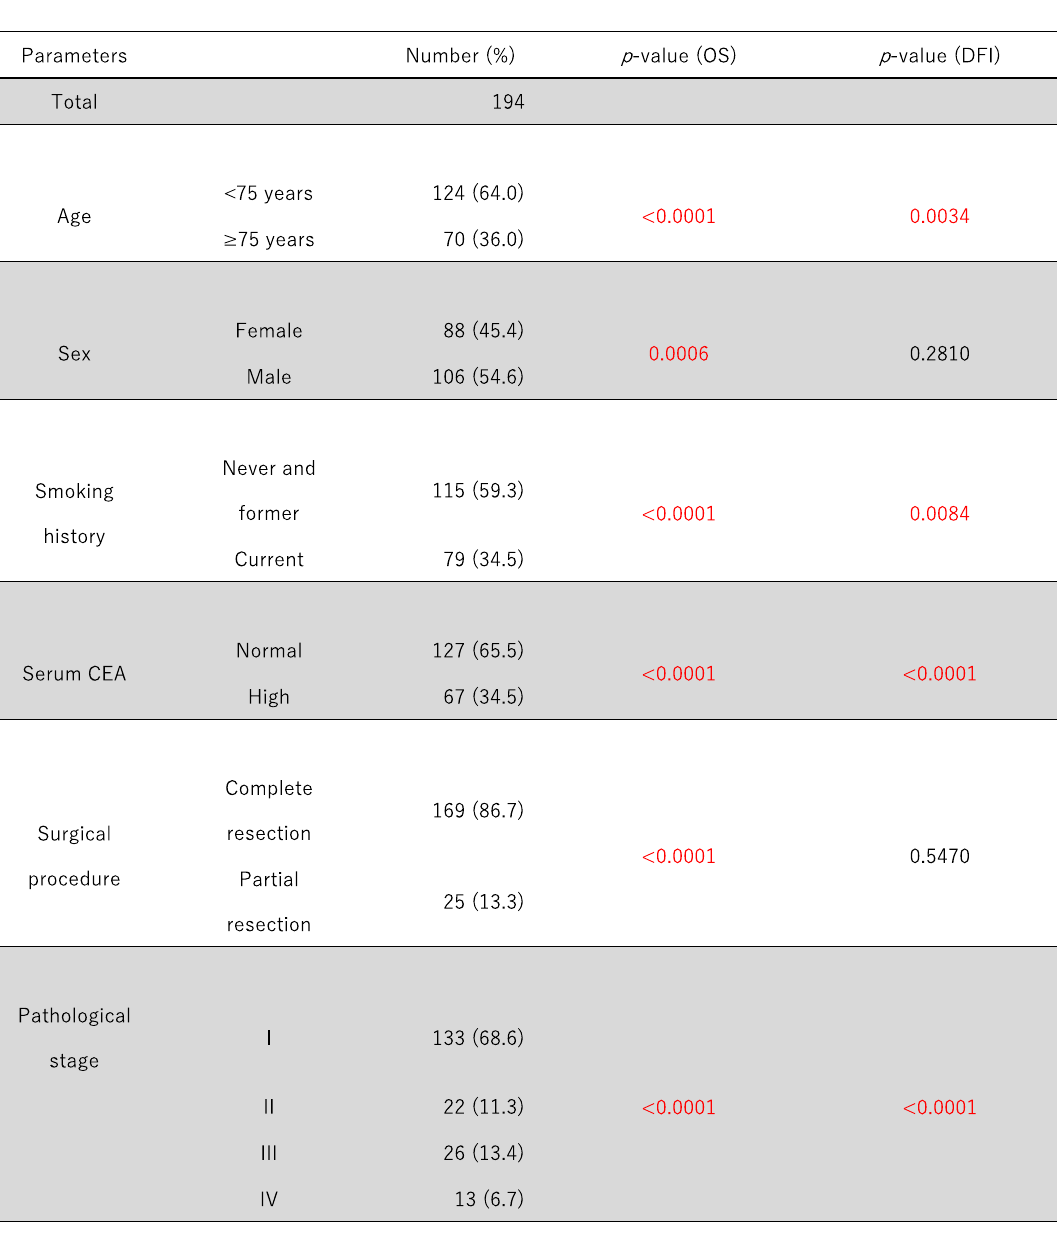
Table 1. Clinicopathological parameters and